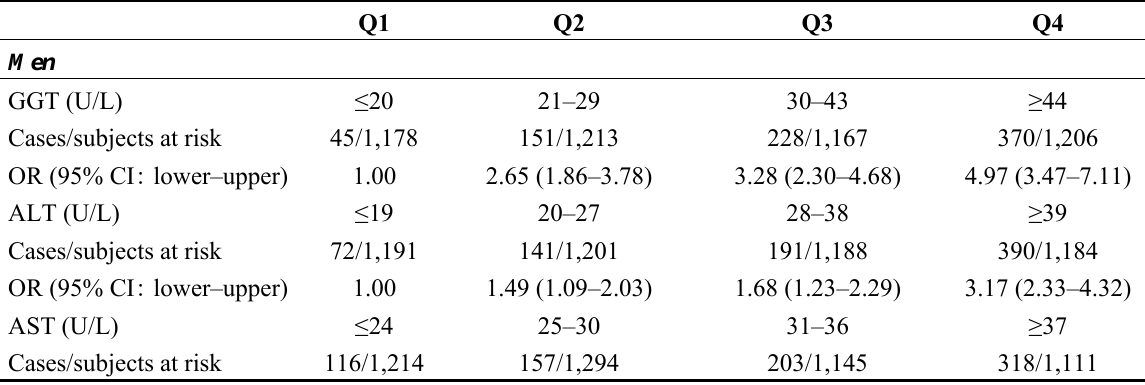
Table 8. Factors associated with elevated BMI by